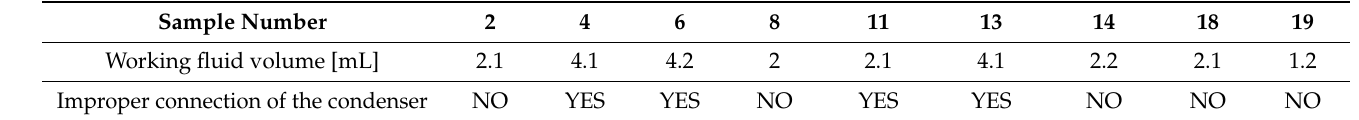
Table 6. Summary of diagnostic test results.